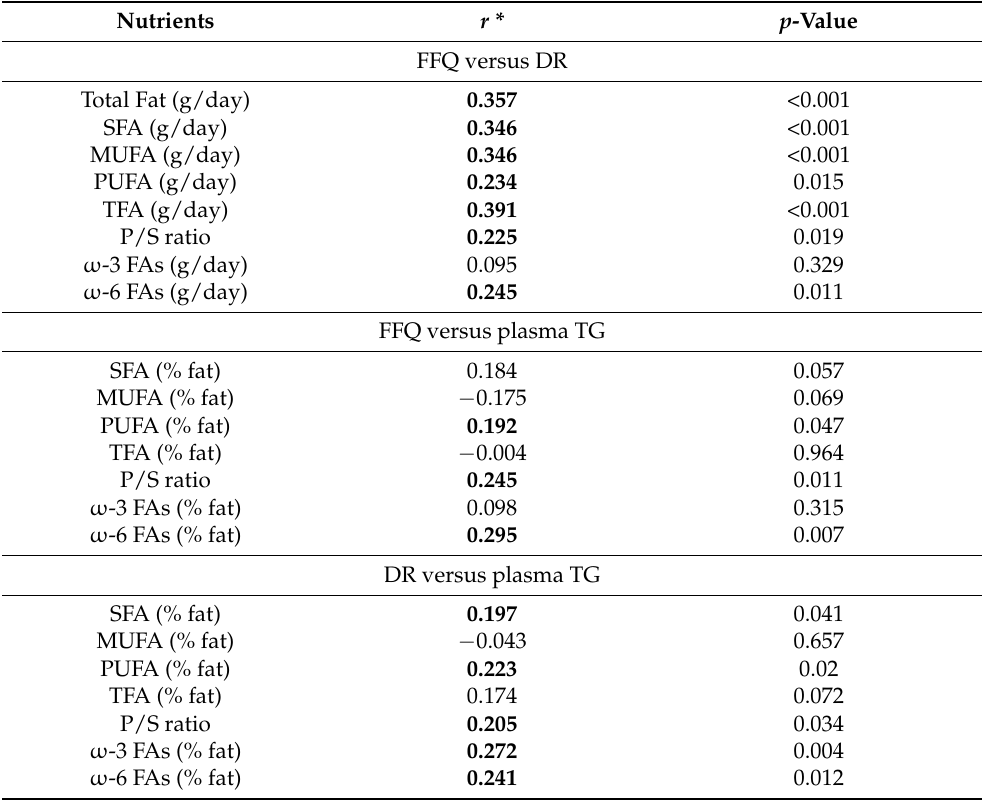
Table 3. Correlations between FFQ, DR and plasma TG as per total fat and fatty acid profiles. Nutrients r * p -Value FFQ versus DR Total Fat (g/day)